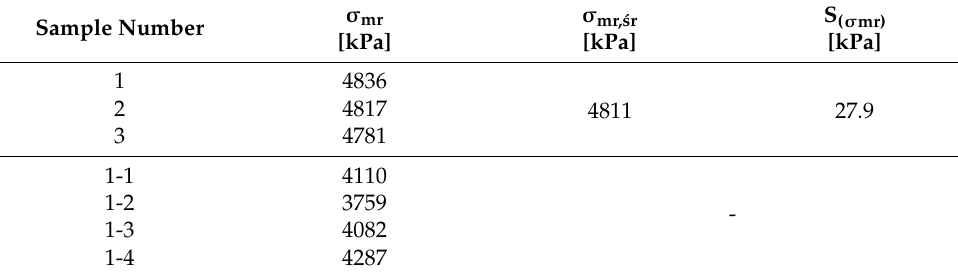
Figure 23. Stress σ relation to strain ε t,ve graph.